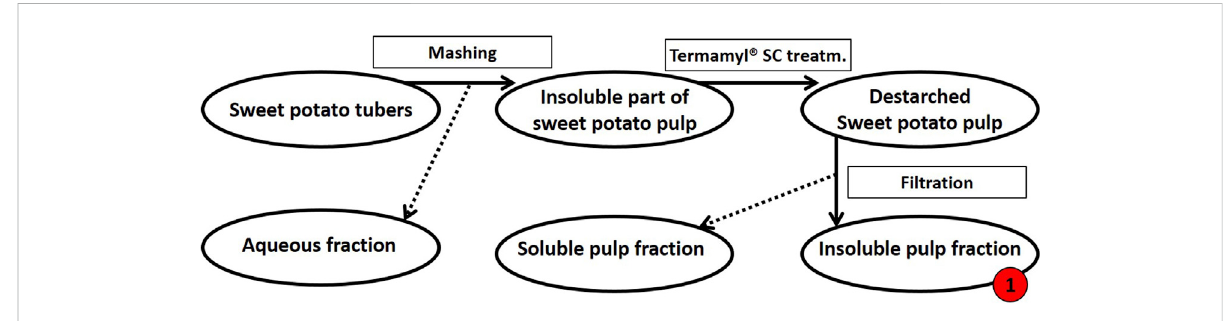
FIGURE 1 Schematic fl ow diagram of the mashing process of sweet potato tubers followed by de-starching. Processing of 500 g fresh sweet potato tubers resulted in a dry matter yield of 112 g insoluble pulp (this destarched insoluble fraction of pulp is called fraction 1, as indicated in red). The insoluble pulp fraction was treated further, see Figure